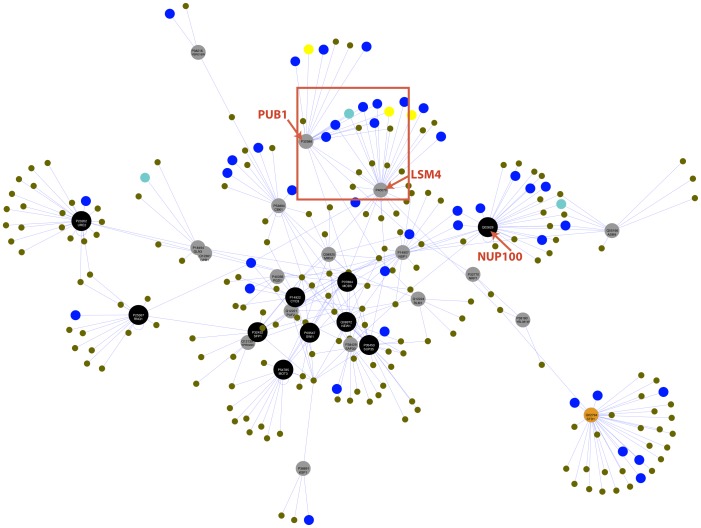
The protein interaction network for the EPD data set.We drew this original picture using the publicly distributed Cytoscape tool that can be used for depicting networks [49], with the data sets of protein interactions that we derived (as described in
Methods
) as input. We have coloured the nodes as follows: --- known prions (KP)  =  BLACK; --- other proteins in the EPD data set  =  GREY; --- EPN data set  =  YELLOW; --- NQPs that are also prion predictions made using the PrionScan algorithm  =  CYAN; --- any other NQP  =  DARK BLUE; --- other interactors  =  BROWN. The non-amyloid prion accessory protein STD1 that underlies the [GAR+] prion [50] (Q02794) is part of the NQP data set that we derived, since it has an N/Q-rich domain. We have coloured its node at the lower right of the network, ORANGE. The prion/prionogenic proteins are labelled with their UniProt accessions and standard gene names. The three EPD hubs are pointed out with red arrows. A red box surrounds common interactors between the LSM4 and PUB1 proteins.